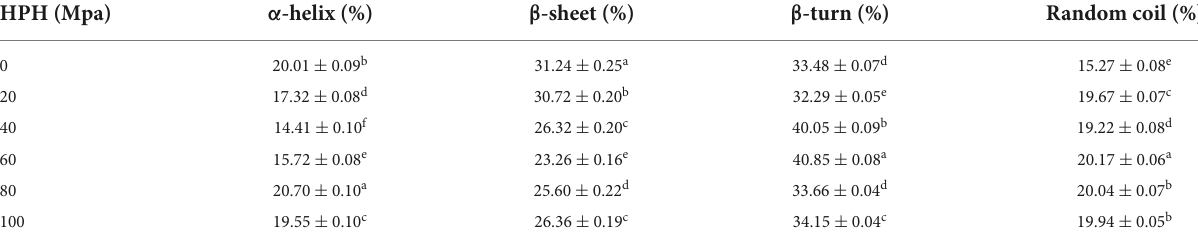
Differentlettersinthedatainthesamecolumnindicatesignificantdifferences( p <